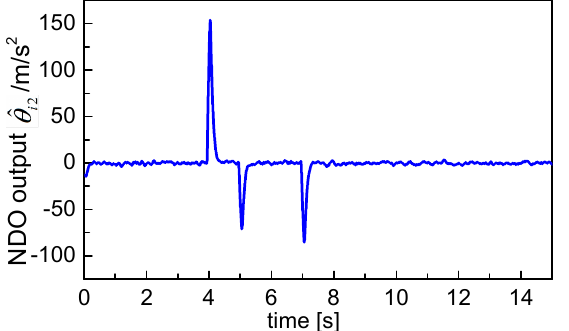
Figure 10. Estimate of